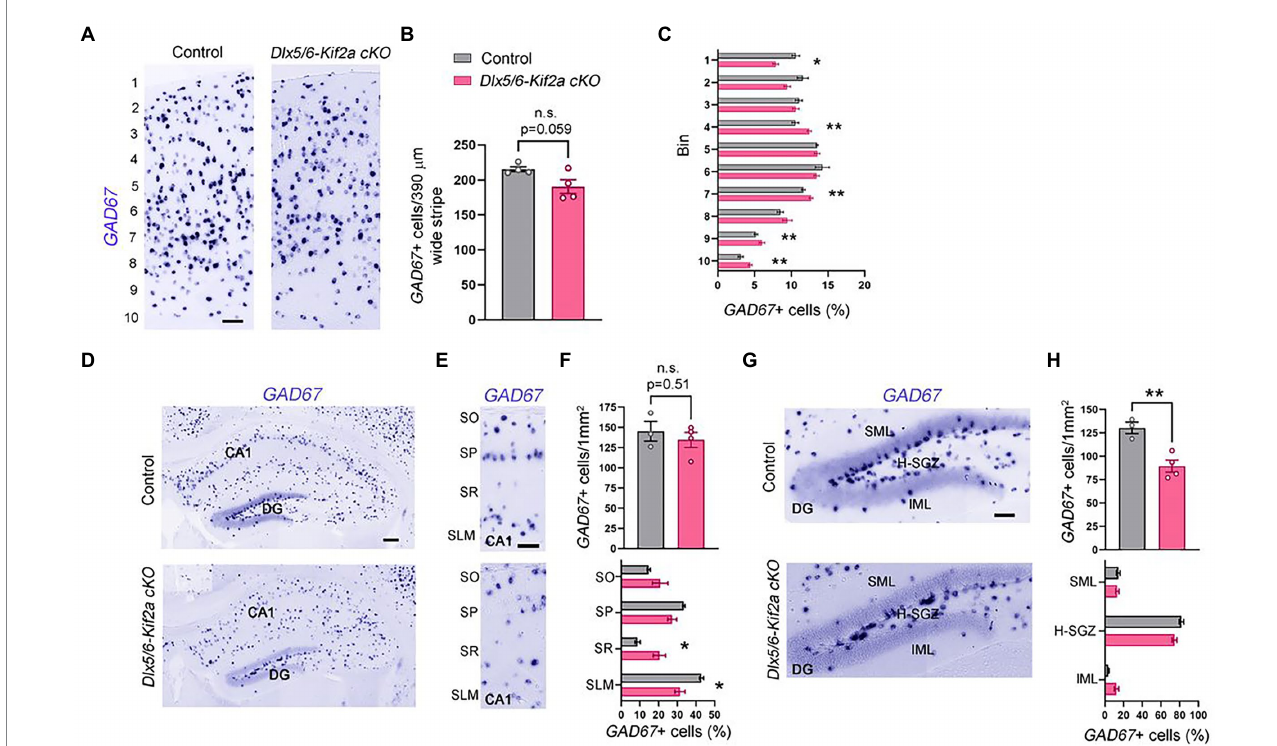
FIGURE 4 KIF2A deficiency alters the distribution of GABAergic neurons in the cortex and hippocampus. (A) Coronal sections at the level of the somatosensory cortex hybridized with GAD67 riboprobe in control and Dlx5/6-Kif2a cKO mice at P40. (B) Mean value of GAD67 -positive neurons in 390 μ m wide stripe (control: 215.3 ± 3.7, n = 4; Dlx5/6-Kif2a cKO : 190.5 ± 10, n = 4). (C) Percentage of GAD67 -positive neurons in each bin in control and Dlx5/6-Kif2a cKO mice. (D) Hippocampal Coronal sections hybridized with GAD67 riboprobe in control and Dlx5/6-Kif2a cKO mice. (E) Magnification of the CA1 region depicting GAD67 -positivecells. (F) Upper panel, mean density of GAD67 -positive neurons in CA1 (control: 145.2 ± 12.2 cells/1 mm 2 , n = 3; Dlx5/6-Kif2a cKO : 134.5 ± 9.4 cells/1 mm 2 n = 4). Lower panel, distribution of GAD67 -positive neurons (percentage of GAD67 -positive cells per subregion in GAD67 -positive cells in CA1 of the corresponding genotype). (G) Magnification of the dentate gyrus (DG) highlighting GAD67- positive cells. (H) Upper panel, mean density of GAD67 - positive neurons in DG (control: 130.2 ± 6.2 cells/1mm 2 , n = 3; Dlx5/6-Kif2a cKO : 89.36 ± 6.6 cells/1mm 2 n = 4). Lower panel, distribution of GAD67 -positive neurons per DG layer and per genotype. DG, dentate gyrus; SO, stratum oriens; SP, stratum pyramidale; SR, stratum radiatum; SLM, stratum lacunosum- moleculare; SML, superior molecular layer; IML, inferior molecular layer; H-SVZ, hilus-subventricular zone. Scale bars (A,E,G) 100 μ m, (D) 200 μ m. Data are represented as mean ± SEM. Values were obtained by unpaired Student’s t-test; * p < 0.05, ** p < 0.01, and *** p < 0.001.